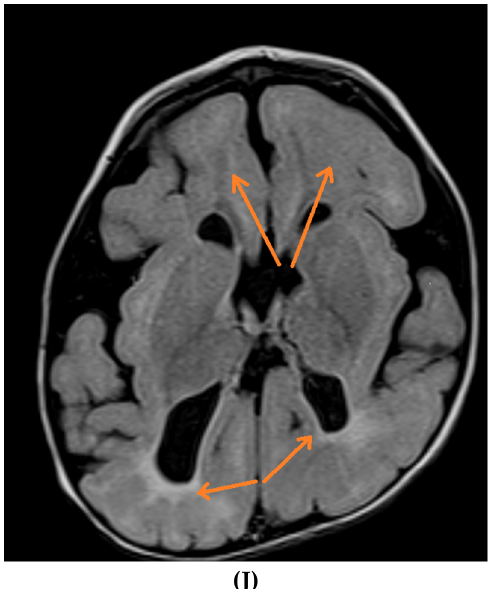
Figure 2. Brain MRIs showing the following ( A ): signs of hypoxia (T2 axial) with diffuse periventricular leukomalacia, enlarged ventricles and global atrophy (arrows); ( B ): delayed myelination in a 2-year-old child with diffuse hyperintense white matter compared to gray matter and brainstem (T2 axial); ( C ): dysgenesis of corpus callosum affecting its rostrum, genu, trunk and splenium (T1 sagittal) (arrows); ( D ): diffuse brain atrophy with enlarged ventricles (T1 axial); ( E ): severe ventricular dilatation (T2 axial) in a child with congenital muscular dystrophy; ( F ): intraventricular hemorrhage III (arrows) and hydrocephalus (T1 axial); ( G ): periventricular leukomalacia (T2 axial) (arrows); ( H ): non-specific white matter changes right precentral (T2 coronal) (arrows); ( I ): right frontal cortical tuber in a child diagnosed with tuberous sclerosis (T2 axial) (arrows); ( J ): PVL and frontal pachygyria (T2 axial) (arrows). Table 1. Summary of clinical characteristics of the cohort.